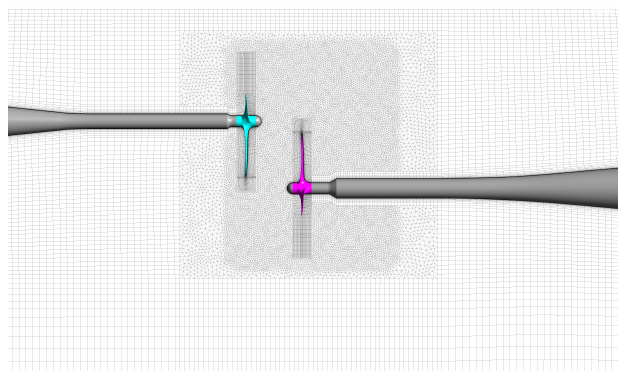
Fig. 3. Final hybrid mesh in double turbine configuration for a radial distance r/D d = 0 . 6 . Block structured hexahedral mesh around the dynamometers and in the farfield and turbine domains. Unstructured tetra dominant mesh in the near field around the